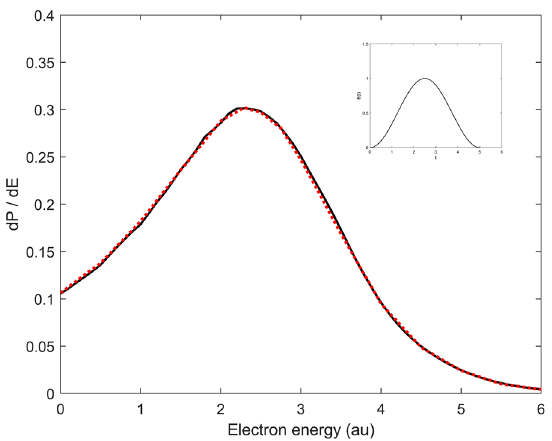
Figure 2. Ionization spektrum of H after irradiation with a half cycle pulse. The electric field of the half cycle pulse is depicted in the inlay, the pulse parameters E sin (ω t ω T f / 2 π/ 2 ) sin 2 (π t / T f ) , E 0 are E ( t ) 0 = − + curve: this work; red dotted curve: results from